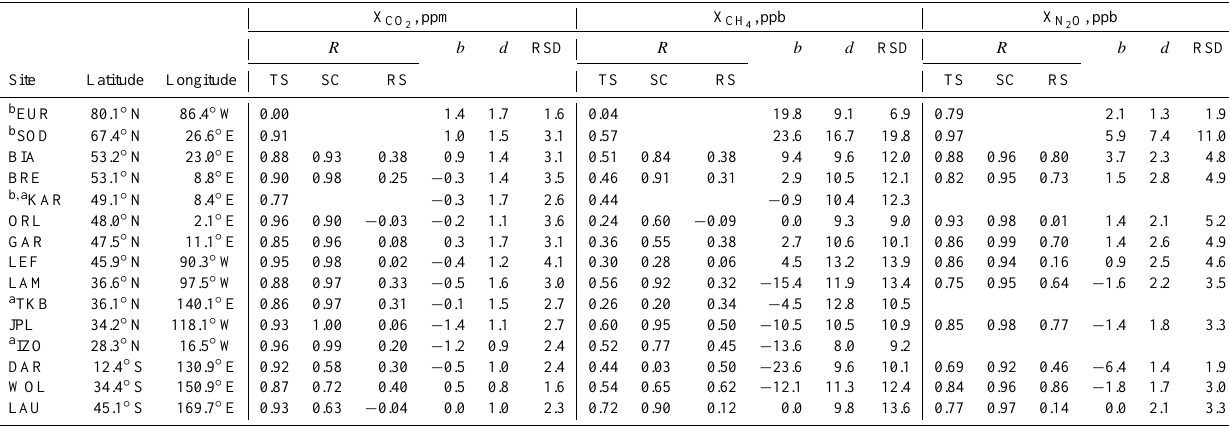
Table 1. List of the TCCON sites used in this study. A comparison between the ACTM and TCCON time series presents the correlation coefficient R , model bias b , model-data difference d , 1- σ standard deviation of residuals (RSD) for observations. We provide three R corresponding to the full time series (TS; Figs. S1–S3 in the Supplement),fitted seasonal cycle (SC; Fig. S5–S7 in the Supplement) and residuals (RS; Figs. S8–S10 in the Supplement) for the observed and model time series.